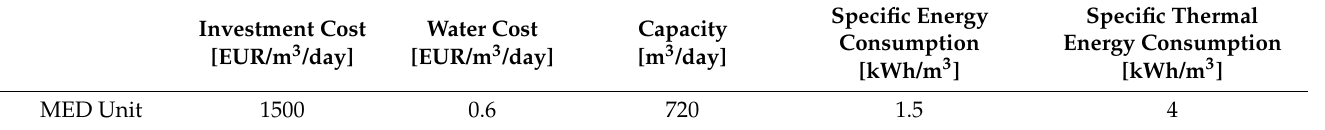
Table 8. Specifications and costs of MED desalination considered.